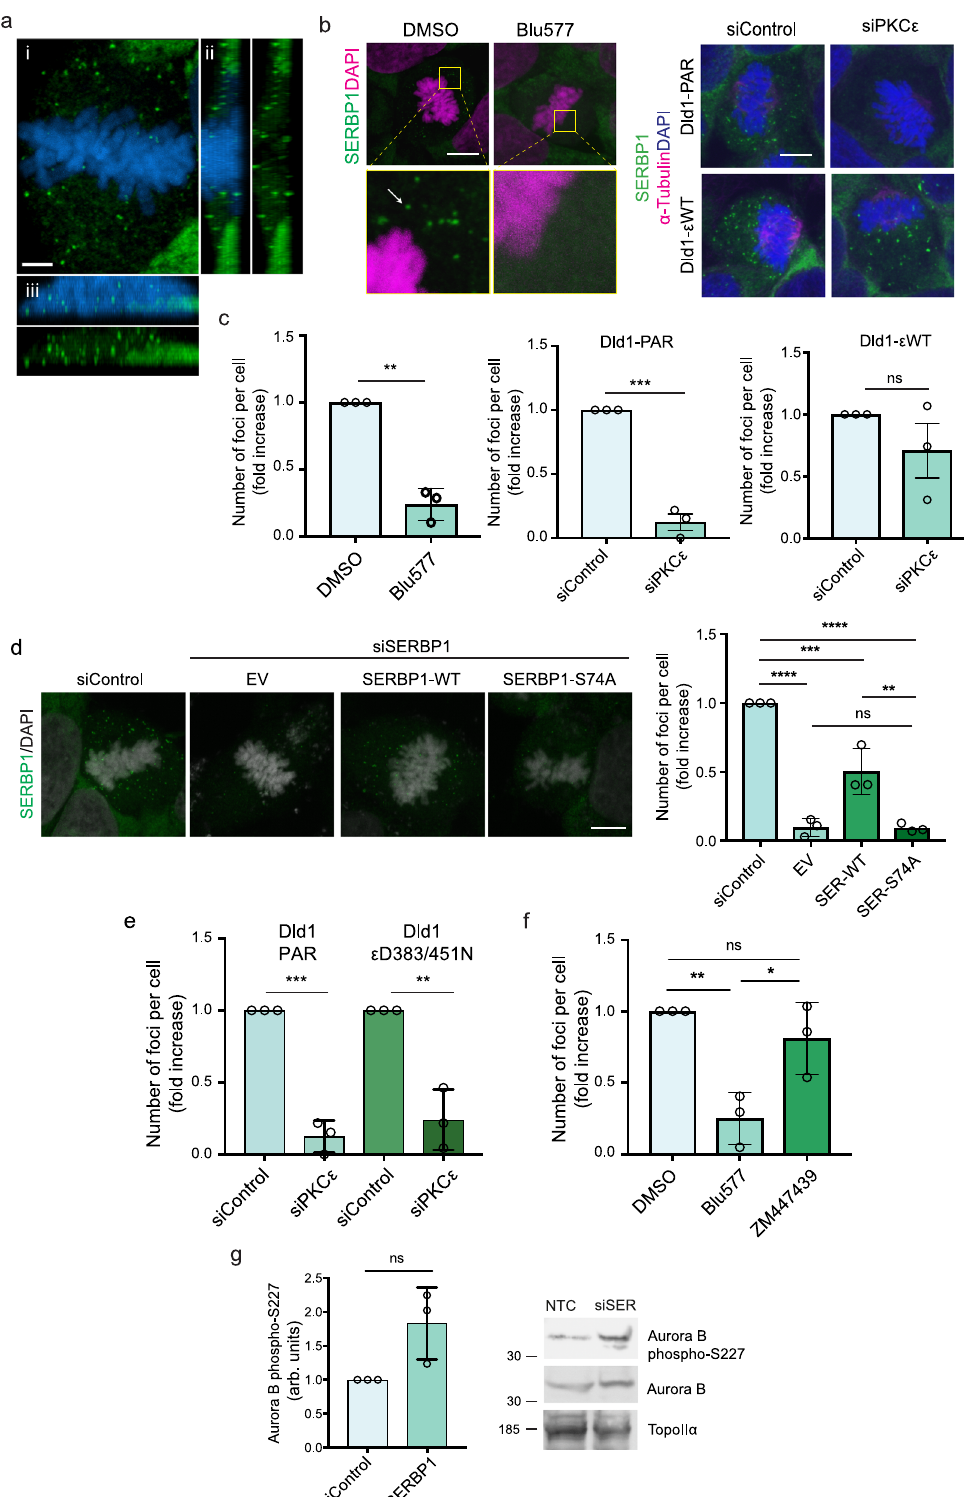
reduced in the M-body/SG fraction 3 S normalised to the sum of all bands (band intensity from 12 to 5 and from 50 to 27, respectively). As observed above (Fig. 4d), G3BP is again under PKC ε control as its expression is reduced from 15 to 7.7. However, the quanti fi cation revealed that LARP4B levels upon translation inhibition are not affected by Blu577 (band intensity from 11 to